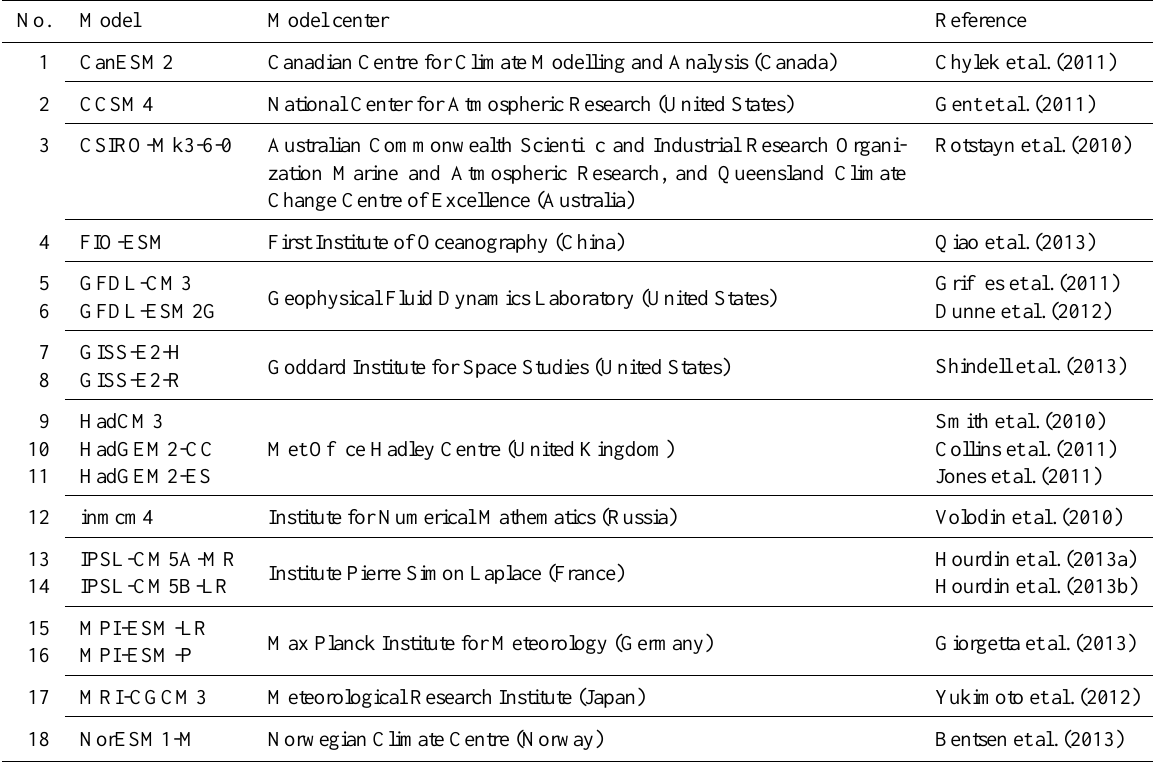
Table 1. List of the CMIP5 models whose output are analyzed in this study. No. Model Model center